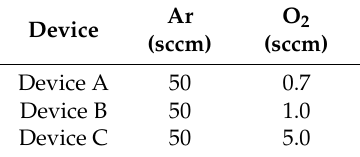
Table 1. Ar/O 2 partial pressure conditions in the radio frequency (RF) sputtering.